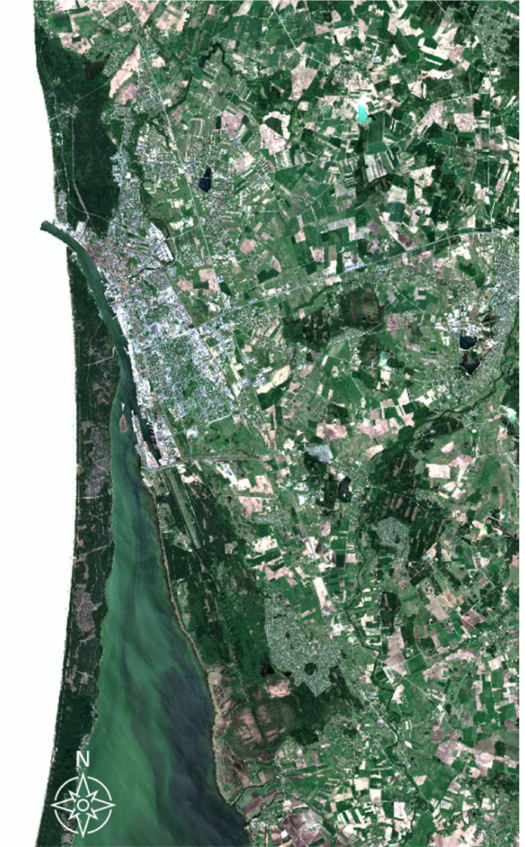
Figure 4. MSI image processed and prepared for